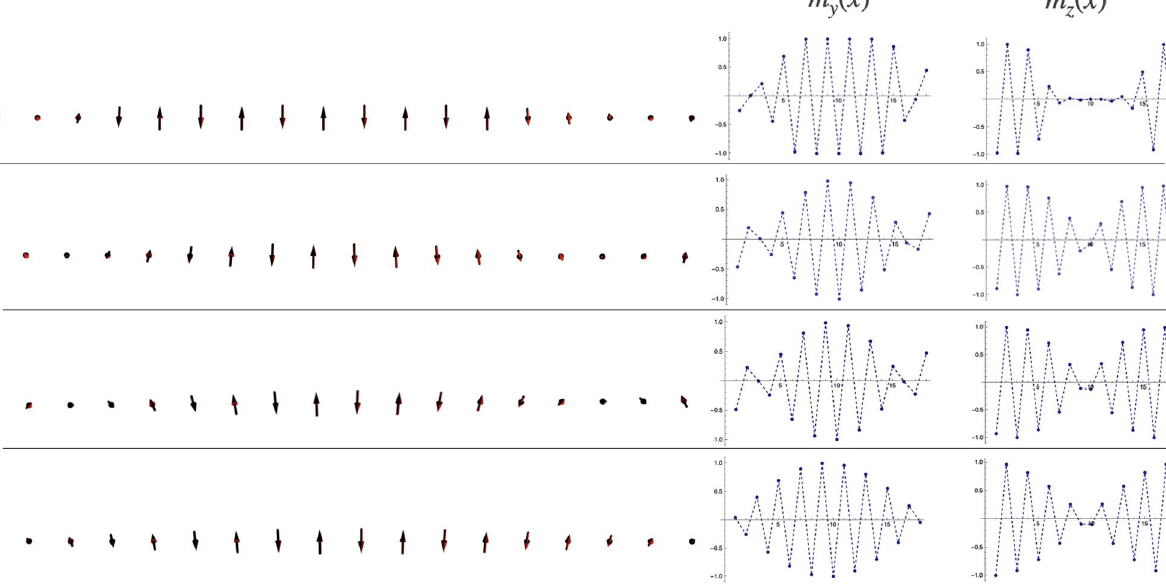
y and z along ˆ ˆ